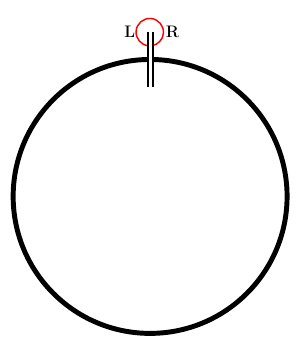
Figure 2 . The spatial part of the Lorentzian traversable wormhole system is depicted schematically. One channel of signal propagation is through the bulk, which takes a certain amount of time due to the bulk causality. The other is the direct propagation through the interaction between the L-R systems, which is